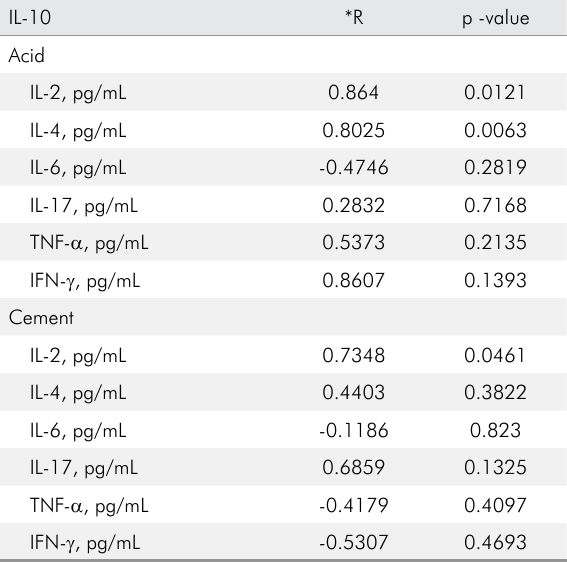
Table 2. Correlation between IL-10 and other cytokines (IL-2, IL-4, IL-6, IL-17, TNF- α and IFN- γ ) in the supernatant of cell cultures after incubation with acid- or cement-treated implant